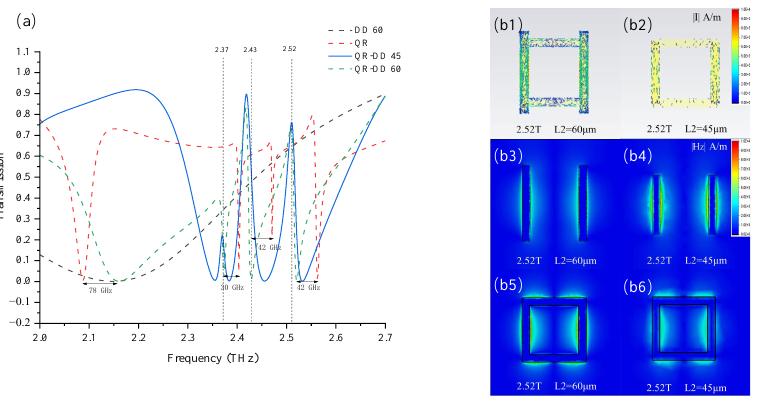
Figure 4. ( a ) A comparison of the simulation transmission spectra based on four different structure combinations is shown; they are marked as DD 60, QR, QR-DD 45, and QR-DD 60. ( b1 , b2 ) The conversions of the Y-axis current flow and the density distribution when the QR-DD structure is excited at 2.52 THz and when L2 is set at 60 µ m or 45 µ m, respectively. The current convergence situation varies depending on whether the variable L2 transforms the QR-DD structure into an EIT state. ( b3 – b6 ) The conversions of absolute Z-axis magnetic field distributions when the two structures are excited at 2.53 THz and the L2 in the structure is set at 60 µ m or 45 µ m. The difference in the magnetic field distribution explains the variability of the excitation mode, and the interaction between the two modes leads to the EIT phenomenon.